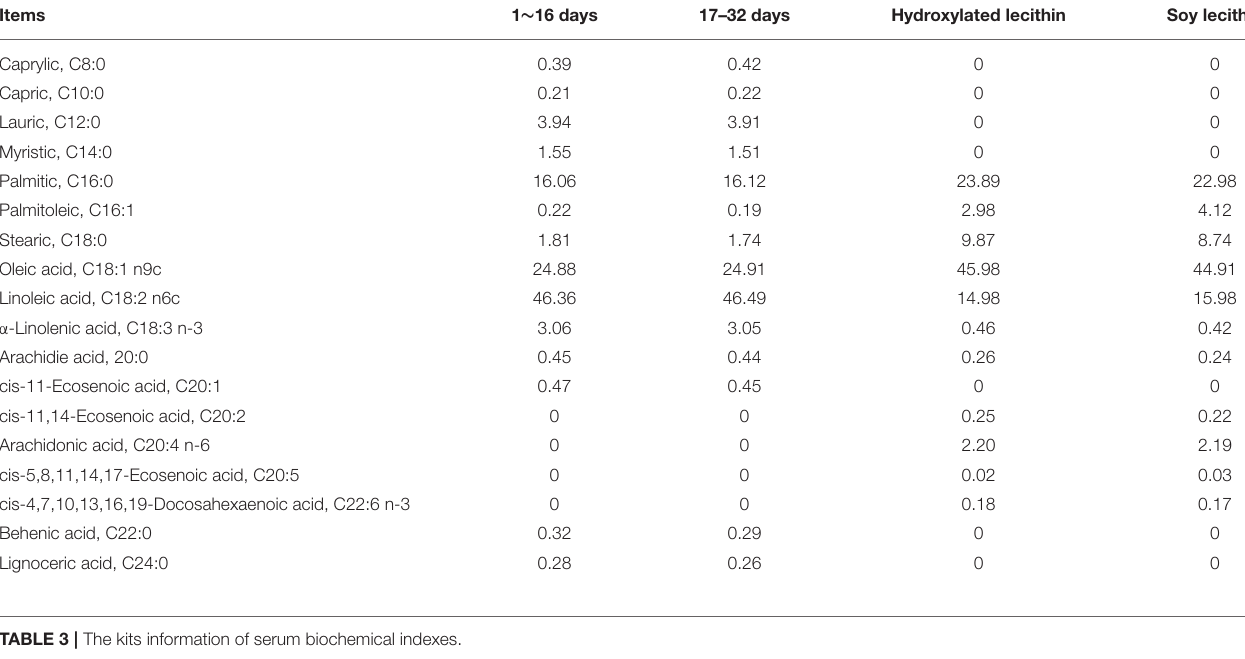
TABLE 2 | The fatty acid composition of the basal experimental diets and lecithin for Jiangnan White goslings (g/100g). Items